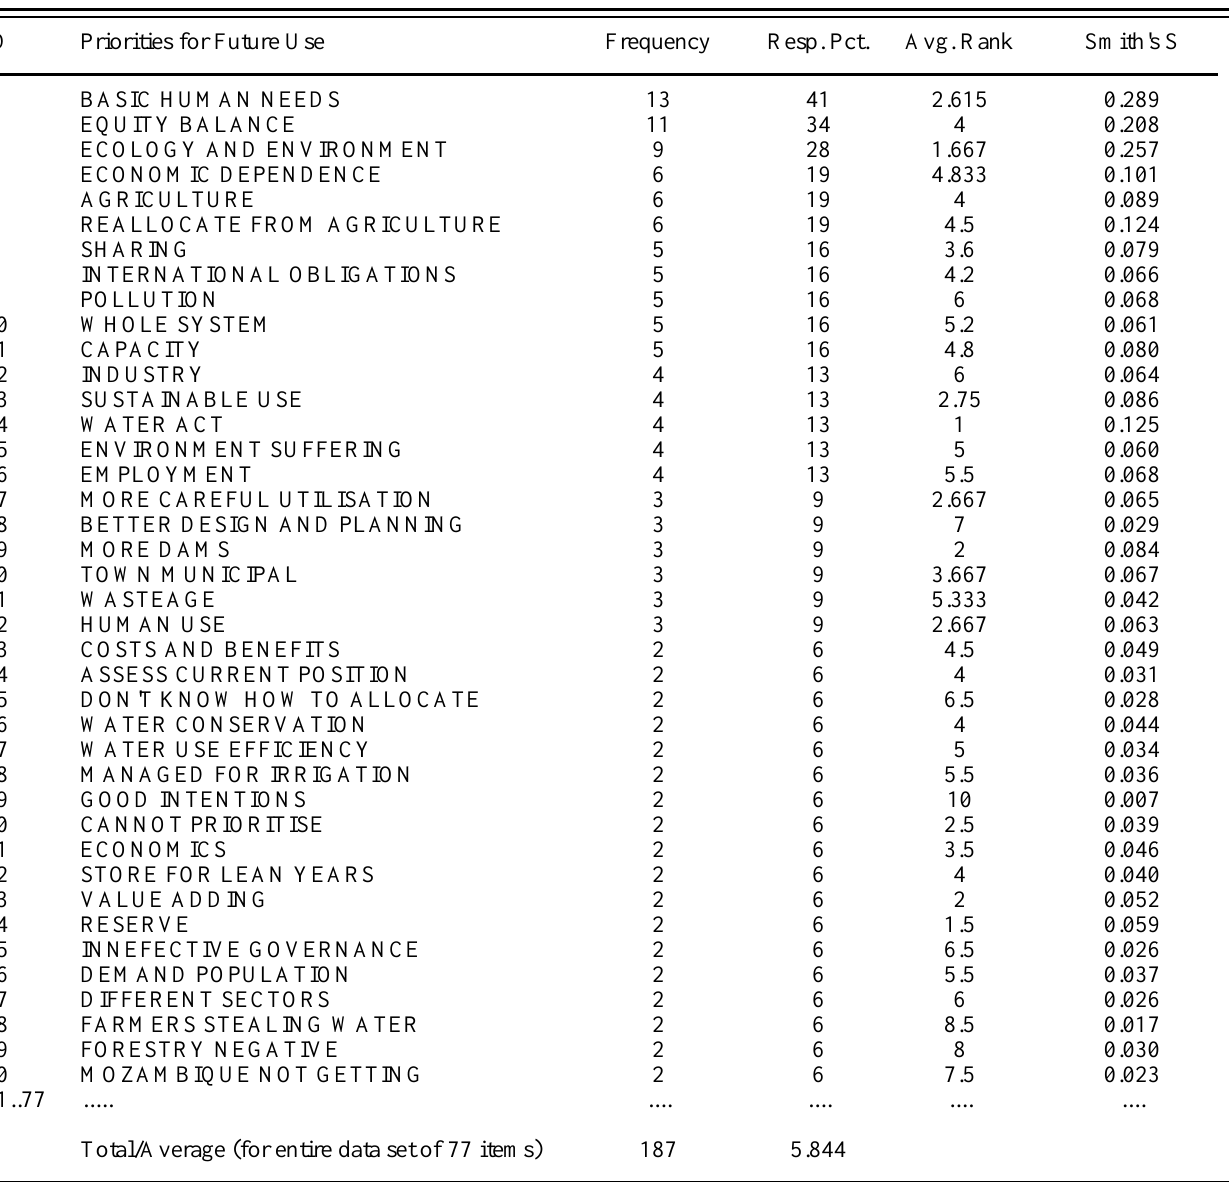
Table 7 . Results of analysis of freelists of “priorities for future water use?”, showing frequency with which interviewees identified priorities, the percentage of interviewees who identified that priority, the average ranking of that priority, and the salience (Smith's S) of the